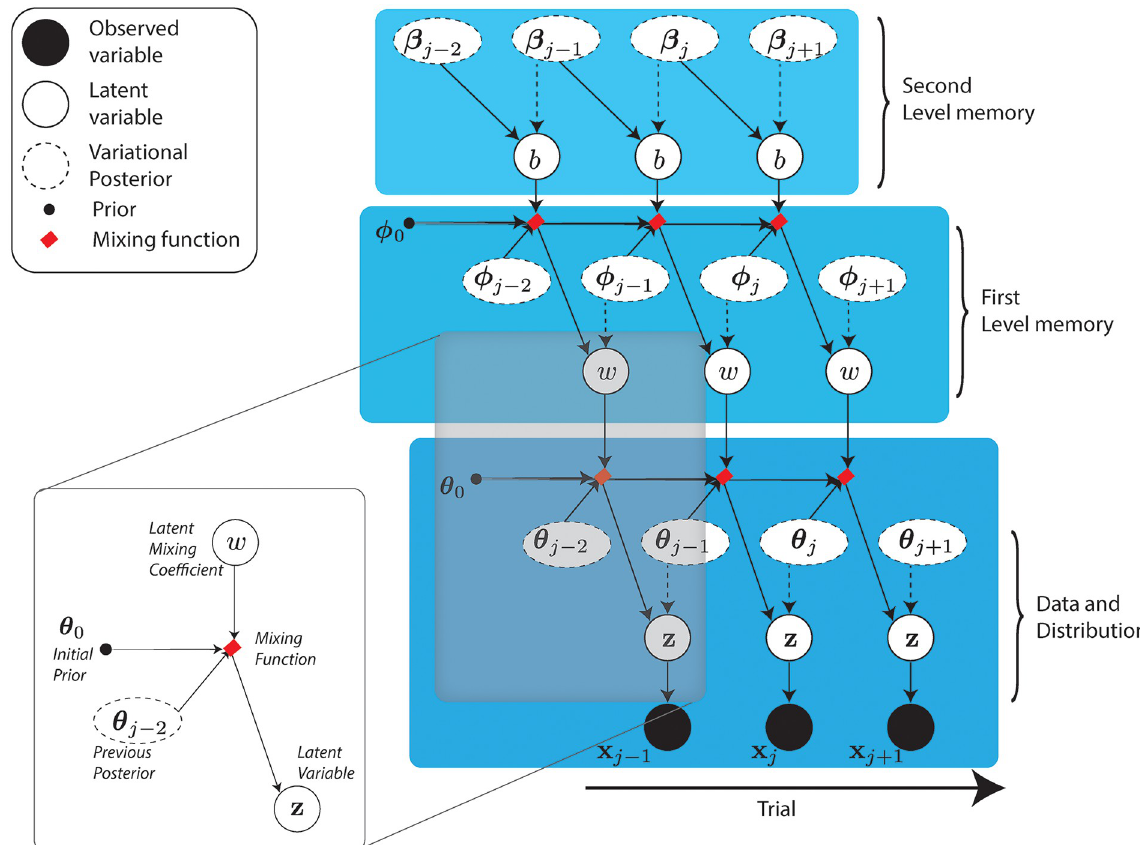
Fig 2. Directed Acyclic Graph of the HAFVF model. Plain circles represent observed variables, white circles represent latent variables and dots represents prior distribution parameters. Dashed circles and dashed arrows represent approximate posteriors and approximate posterior dependencies. A weighted prior latent node is